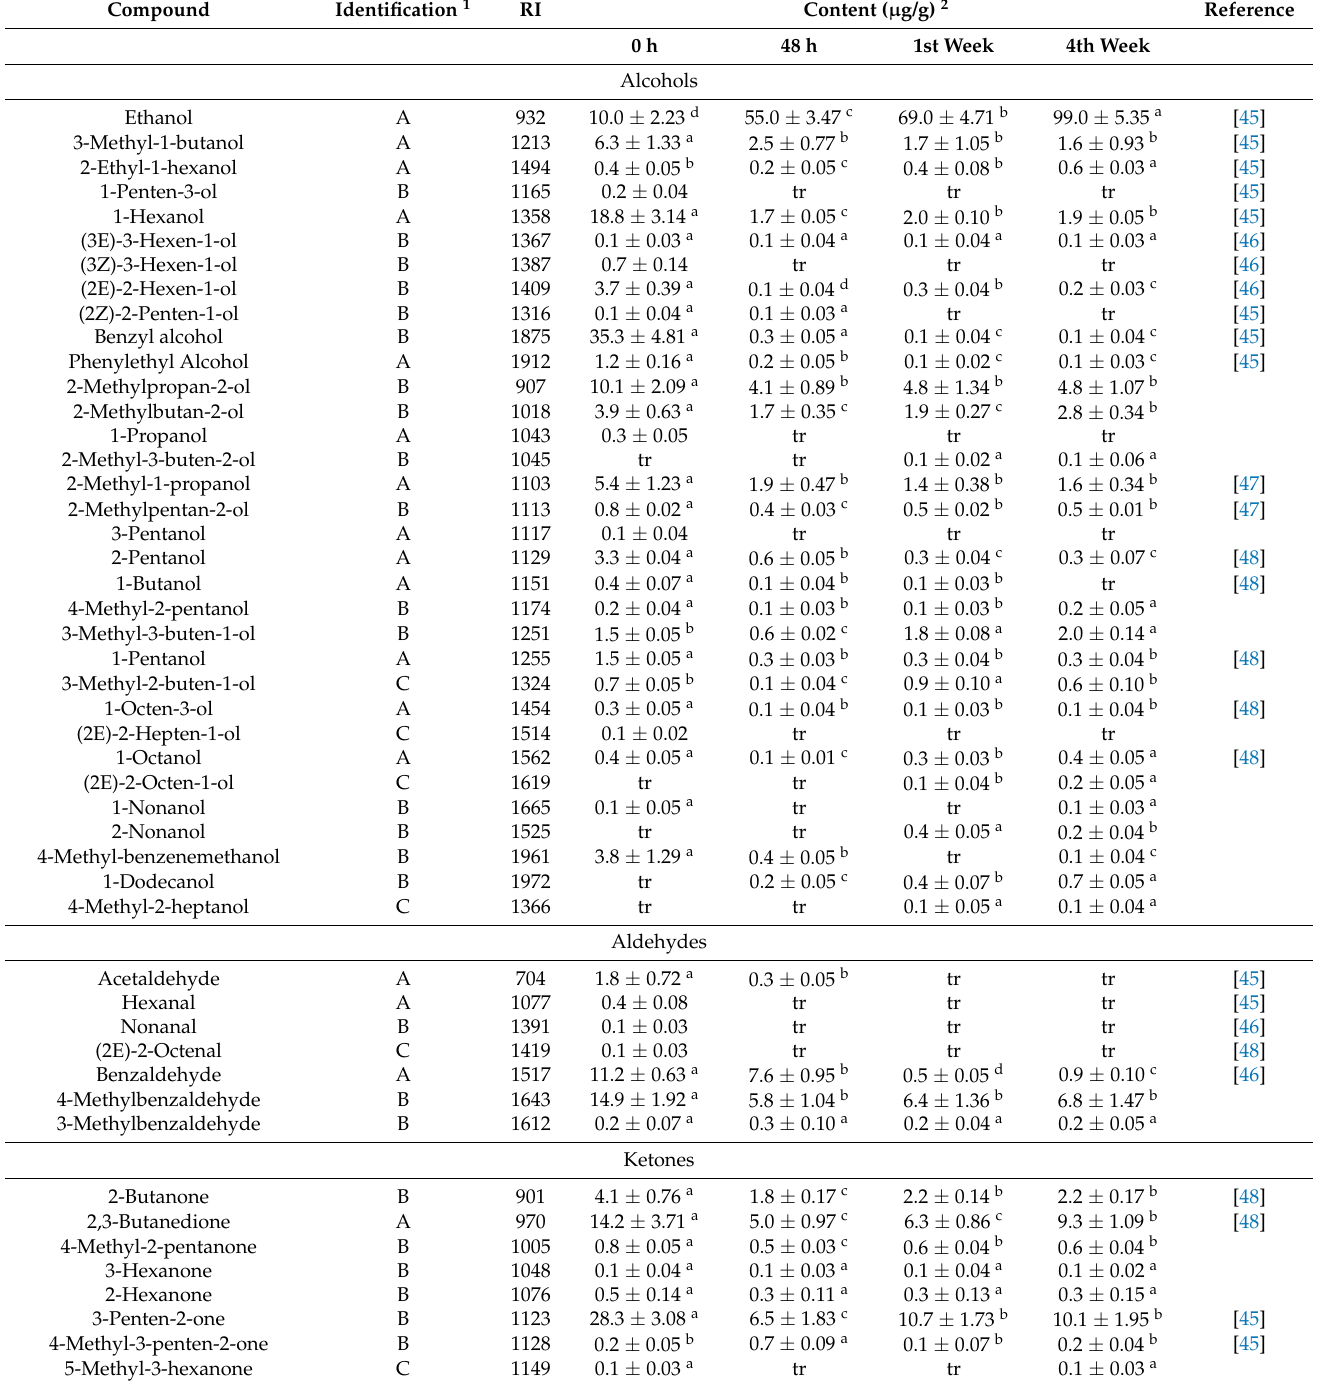
5-methyl-3-hexanone, 4-methyl-2-heptanone (ketones), ethyl acetate and methyl benzoate (organic esters), hexanoic acid (organic acids), eucalyptol, and terpinen-4-ol [44–48]. The outcome provided by these identified compounds highlights the stability of the product, as the high content of volatiles was retained even at the fourth week of fermentation at 4 ◦ C (Table 4). Table 4. Volatile compounds identified in the fermented chokeberry juice at 0 h, 48 h, and during fermentation at 4 ◦ C.